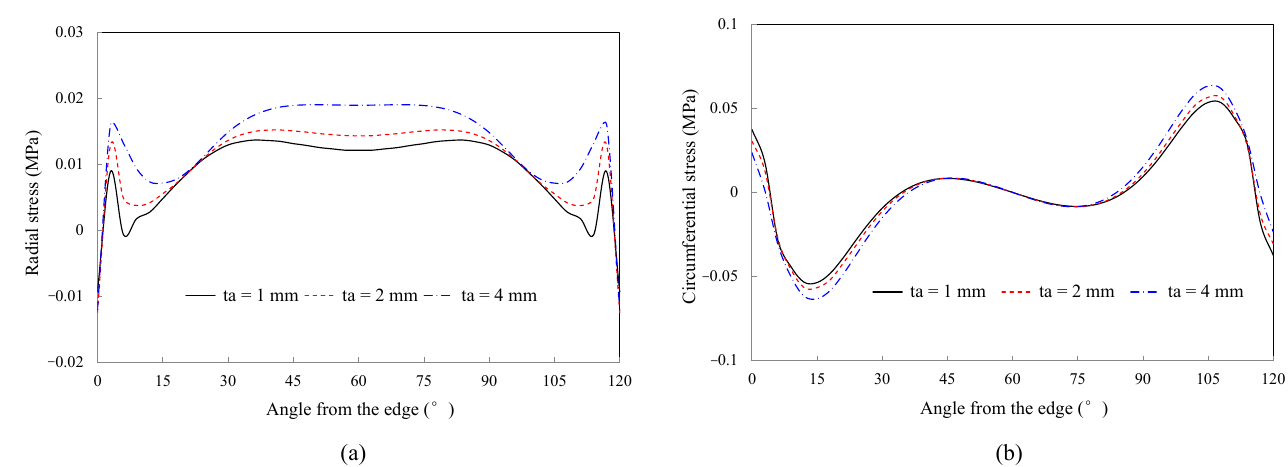
Figure 13. Effect of t a on the reinforced interface stresses: ( a ) radial stress; ( b ) circumferential stress.